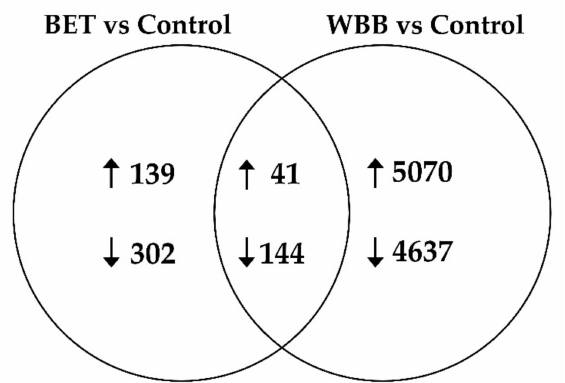
Figure 6. Venn diagram summarization of the di ff erential expression comparisons. The number of di ff erentially expressed genes (DEGs) in each circle represents the amount of DEGs between the di ff erent comparisons betulin (BET) versus control and white birch bark (WBB) versus control. Only the annotated genes were included. The overlapping number specifies the mutual DEGs between the distinctive comparisons and the non-overlapping numbers define the genes exclusive to each condition. Indicated in the diagram are the numbers of up-regulated ( ↑ ) and down-regulated DEGs ( ↓